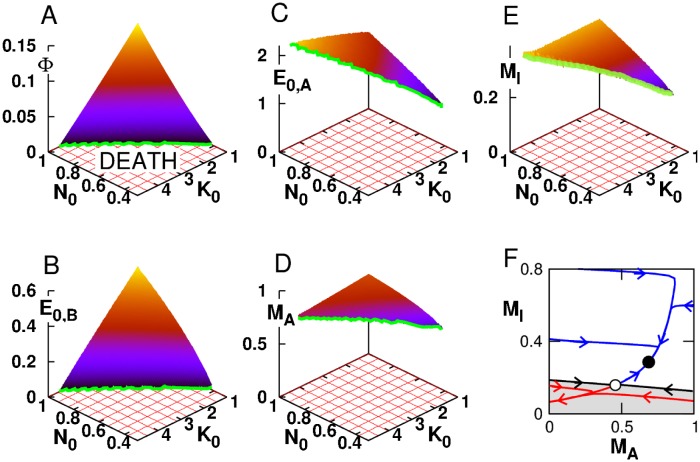
Optimal steady-state solutions.Case where rate coefficients Ei are optimized parameters. Properties of the optimal steady-state solution (aN,K = 0) as a function of the stationary level of nutrient N0 and demand K0: (A) Growth rate Φ where green line corresponds to Φ = 0; (B-C) Stationary enzyme level E0,B and E0,A; (D,E) Stable fixed point coordinate MA and MI; (F) Example of phase space portrait and trajectories for N0 = 0.8 and K0 = 2 where black and white circles indicate stable and unstable fixed points and the black line separates the viability domain (white) and metabolic collapse domain (gray).